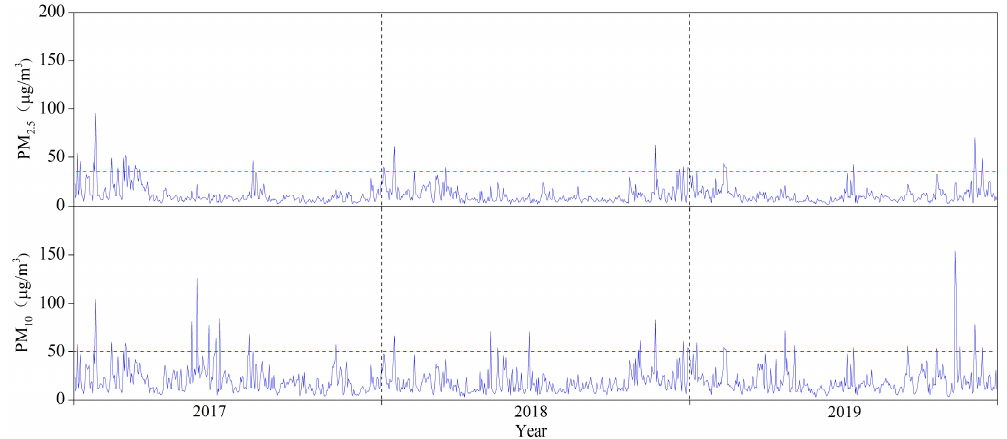
Figure 2. Daily mean concentrations of PM 2.5 and PM 10 in Akedala station from 1 January 2017 to 31 December 2019 (the red dotted lines represent the limit of the Class I standard of CAAQS for PM 2.5 and PM 10 daily mean concentrations).